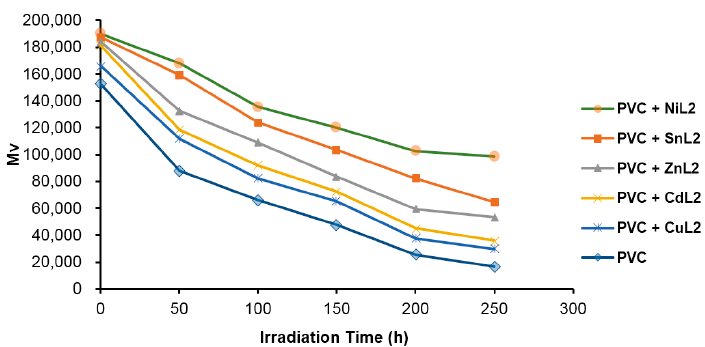
Figure 7. Effect of irradiation time (250 h) on M V (g/mol) for PVC films (40 µ m thickness) containing ML 2 (0.5 wt %).